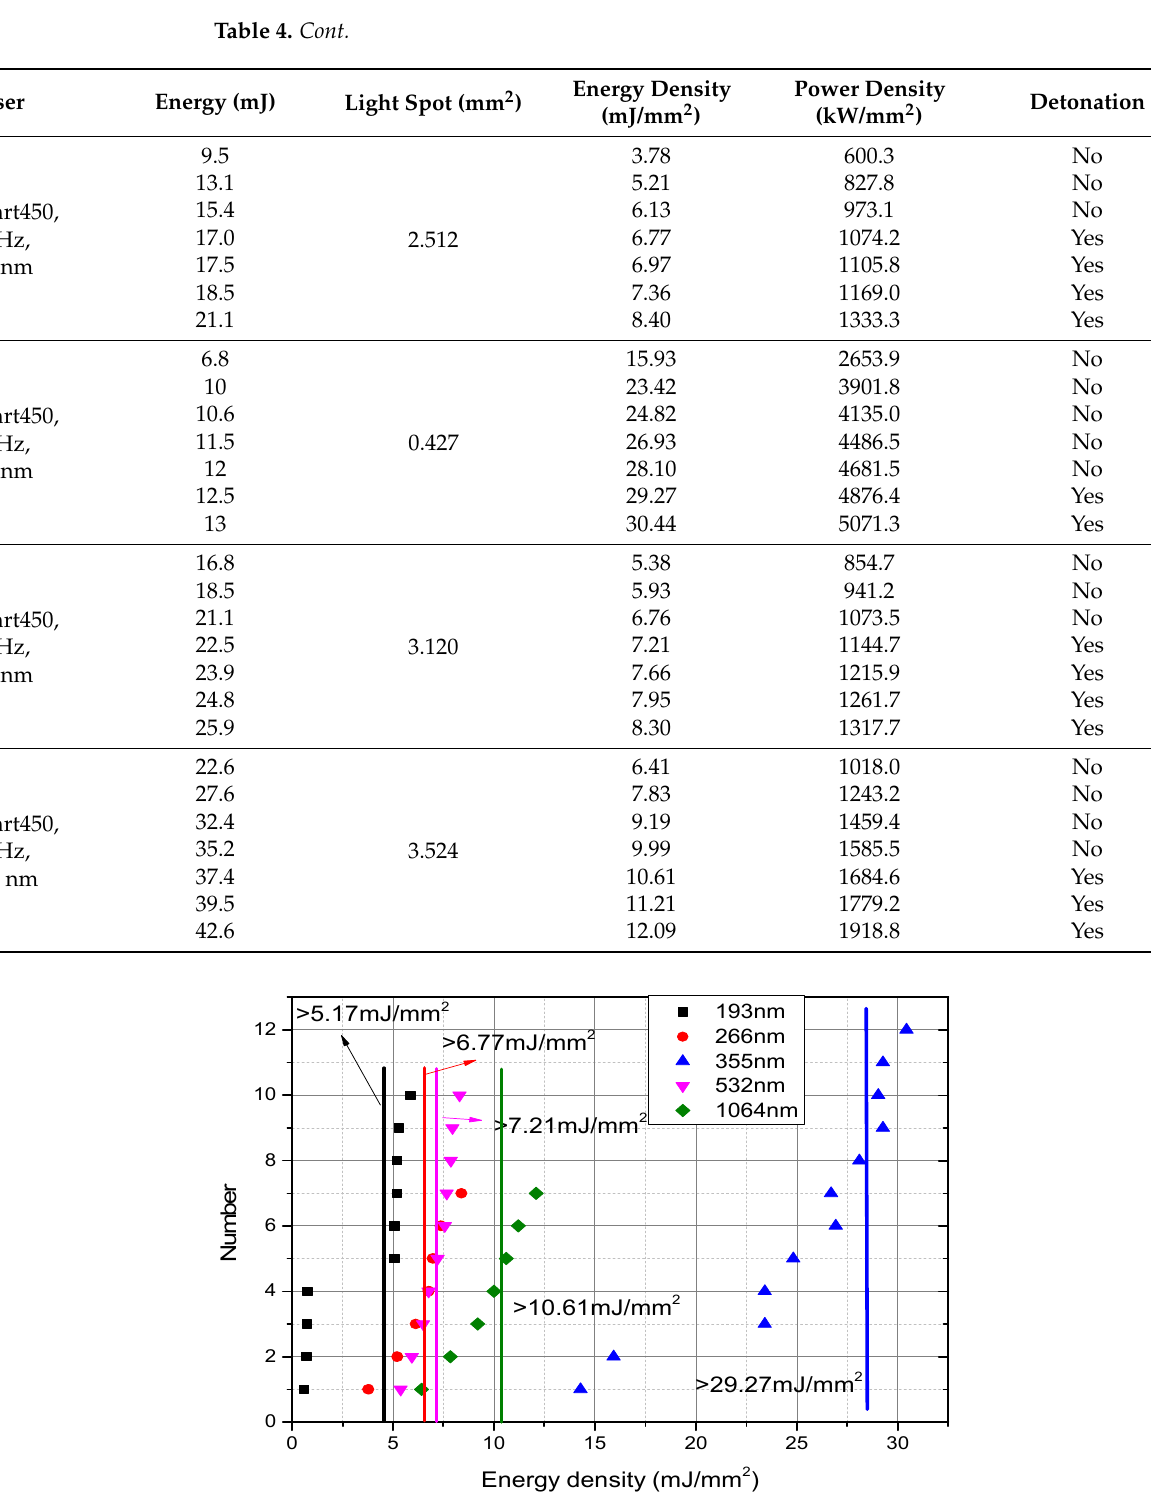
Figure 10. Experimental threshold of laser initiation SASN. From the experimental results, it is seen that SASN is detonated reliably under different wavelengths of pulsed laser, and the complete detonation is realized only when the energy density is greater than 5.07 mJ/mm 2 at 193 nm, 6.77 mJ/mm 2 at 266 nm, 7.21 mJ/mm 2 at 532 nm, and 10.61 mJ/mm 2 at 1064 nm. This also verifies that SASN light absorption reduces with the wavelength (see Figure 10). However, the complete detonation is